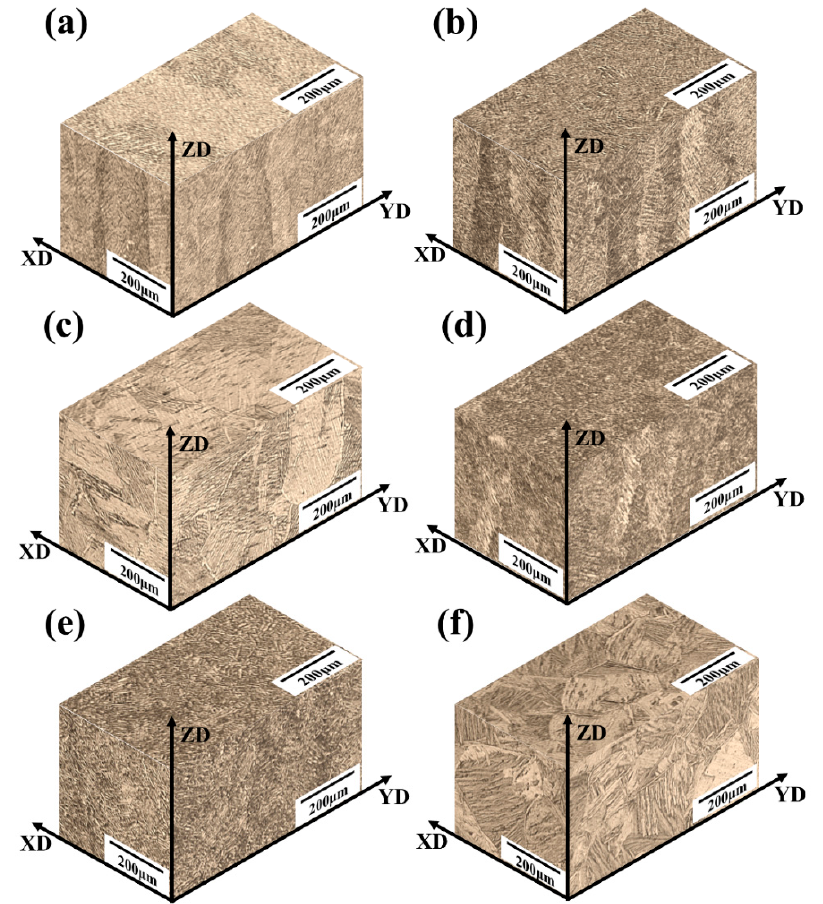
Figure 4. Representative 3D microstructures (OM) of Ti6Al4V following heat treatment schedules: ( a ) 850FC, ( b ) 950FC, ( c ) 1050FC, ( d ) 850WAC, ( e ) 950WAC, ( f ) 1050WAC.